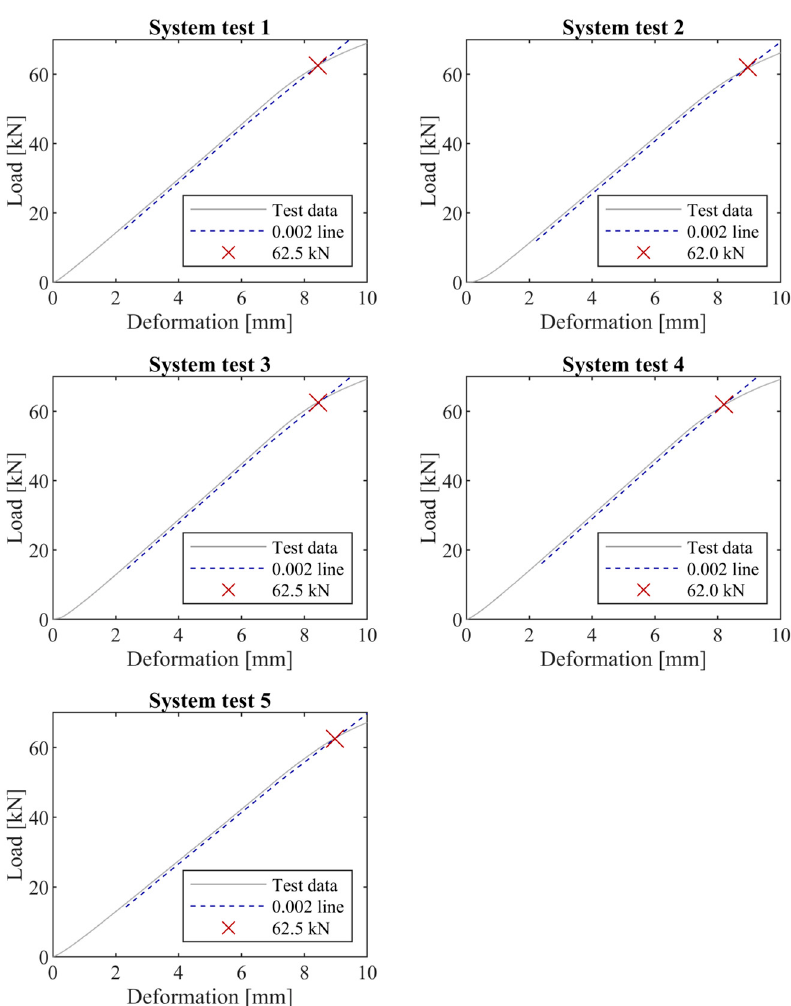
Figure 14. Translation of the linear regime (0.14 mm) and identification of the yielding threshold.